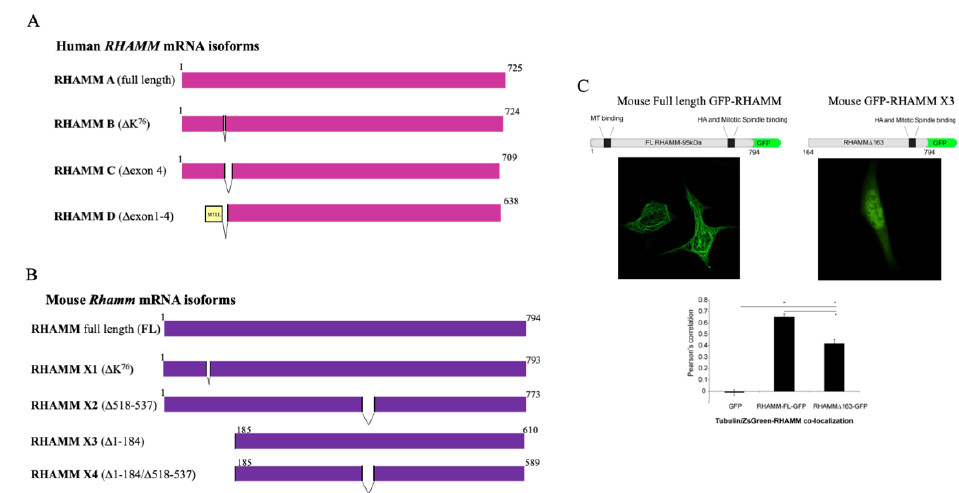
Figure 5. Isoform structures of RHAMM in ( A ) human and ( B ) mouse genomes. RHAMM isoforms are generated by alternative splicing and/or alternate start site/codon usage. ( C ) Full-length mouse GFP-RHAMM decorates interphase microtubules, while mouse GFP-RHAMM X3 is more diffuse and accumulates in the nucleus.